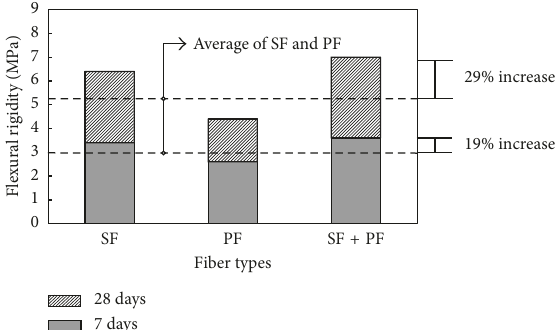
Figure 5: Influence of fiber combination on flexural strength of concrete mixtures (the dotted line expresses the average value of SF and PF).